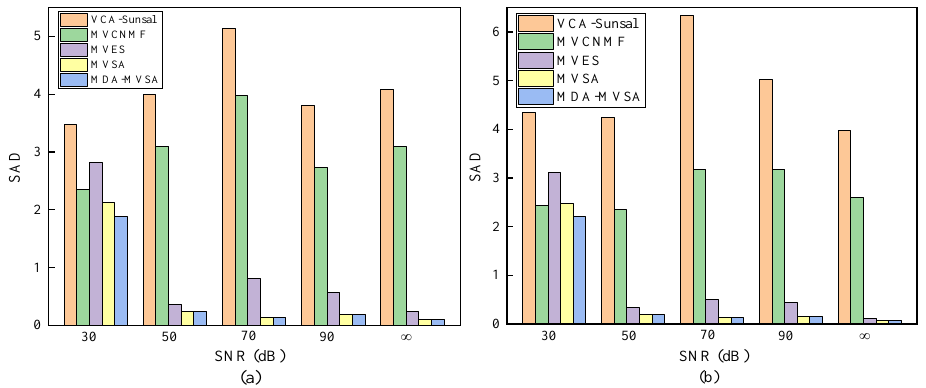
Figure 4. Spectral angle distance (SAD) performance for different endmember extraction algorithms on ( a ) synthetic data with pure pixels under different noise levels and ( b ) synthetic data with nonpure pixels under different noise levels. The two types of synthetic data both have 3364 pixel points and five endmembers under different noise levels.